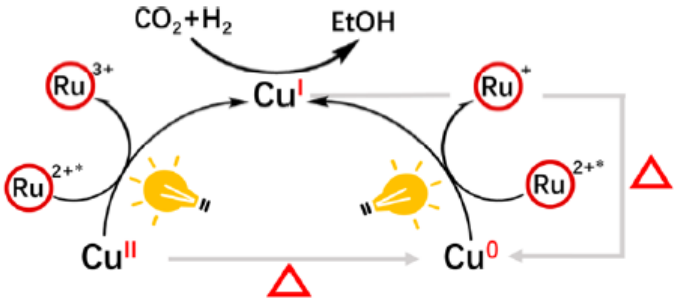
Figure 8. Generation of Cu I via light irradiation over a Cu II (H x PO 4 ) y @Ru-Uio catalyst (* represents the active site). Reproduced with permission from reference [77].